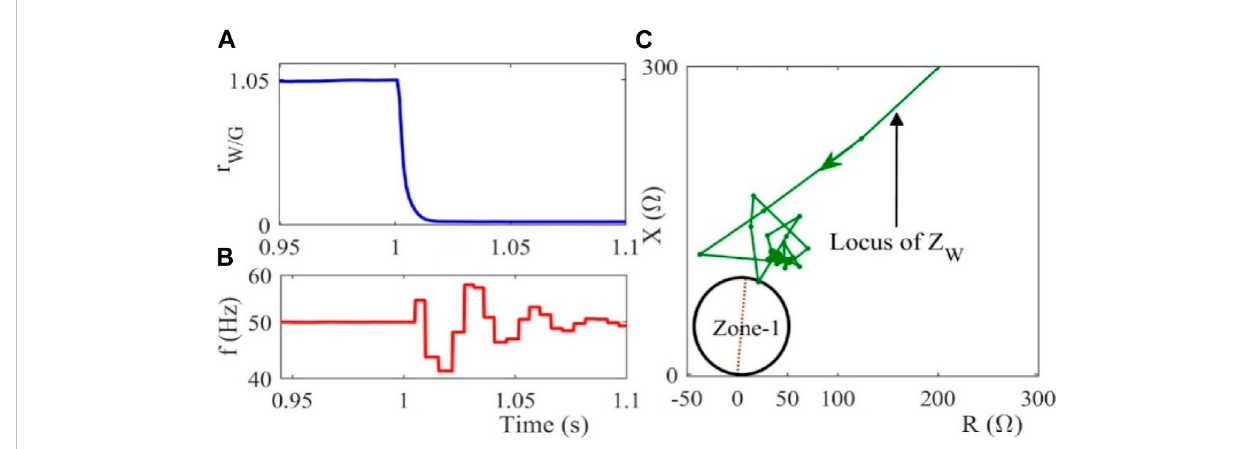
FIGURE 3 Demonstration of the impacts of three-phase faults on the performance relay R W protecting the large-scale DFIG wind farm-connected TL.